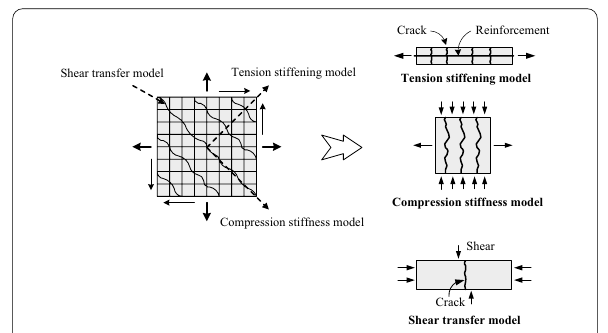
Fig. 1 Construction of the cracked concrete